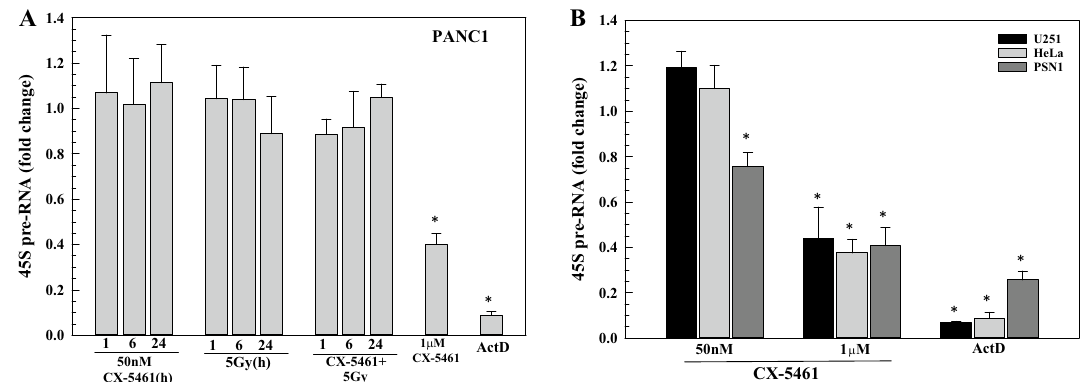
Figure 2. Effect of the radiosensitizing dose (50 nM) of CX-5461 on 45S rRNA transcription. (A) PANC1 cells were treated with 50 nM CX-5461 1 h prior to irradiation (5 Gy); RNA was harvested at the indicated times with 45S transcript levels determined by qPCR analysis and normalization to 7SK lncRNA. Treatment with 1 µM CX-5461 for 1 h and 20 ng/mL actinomycin D (ActD) for 2 h were used as positive controls for inhibition of 45S transcription. (B) U251, HeLa, and PSN1 cells were treated with 50 nM CX-5461 (24 h), 1 µM CX-5461 (1 h) or 20 ng/mL ActD (2 h). 45S transcript levels were then determined by qPCR analysis with normalization to 7SK lncRNA. Values represent the mean ± SEM for three independent experiments. * p < 0.05 by Student’s